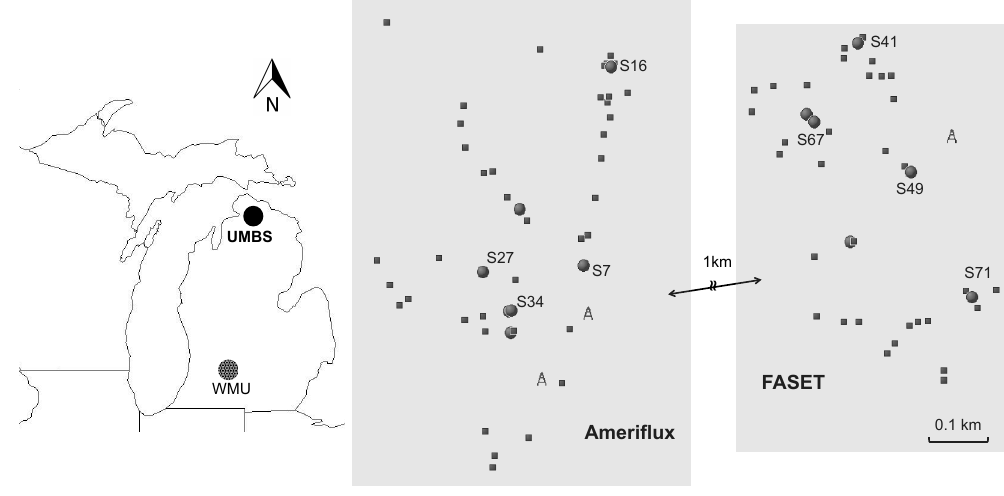
Fig. 1. Distribution of individual trees within the sampling site at UMBS. Squares: each understory tree, circles: trees with relatively high concentration of